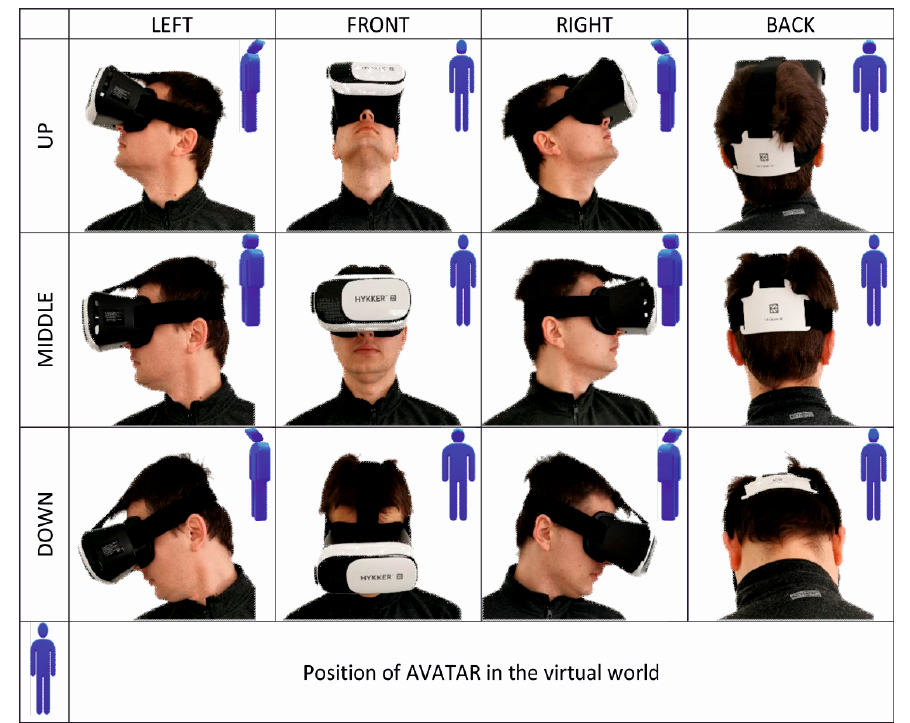
Figure 12. A tour of the virtual design. Source: prepared by the author.